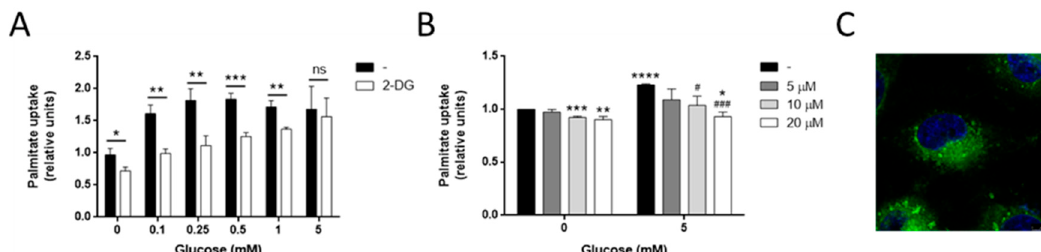
Figure 6. Utilization of glucose for palmitate metabolism in MDA-MB-231 cells. ( A ) Palmitate uptake in the presence of different concentrations of glucose along with 5 mM 2-deoxyglucose (2-DG) or ( B ) different concentrations of adipostatin A. ( C ) Representative photograph of BODIPY FL C 16 intracellular location in MDA-MB-231 cells. Bar scale = 8 µ m. All of the experiments were performed after 30 min of fasting and 30 min of incubation with 0.5 mM palmitate, 2 µ M BODIPY FL C 16 , and indicated concentrations of glucose. Data are expressed as means ± SD of three independent experiments. * p < 0.05, ** p < 0.01, *** p < 0.001, **** p < 0.0001 versus condition without 2-DG ( A ) or with only palmitate ( B ). # p < 0.05, ### p < 0.001 versus palmitate and glucose ( B ).